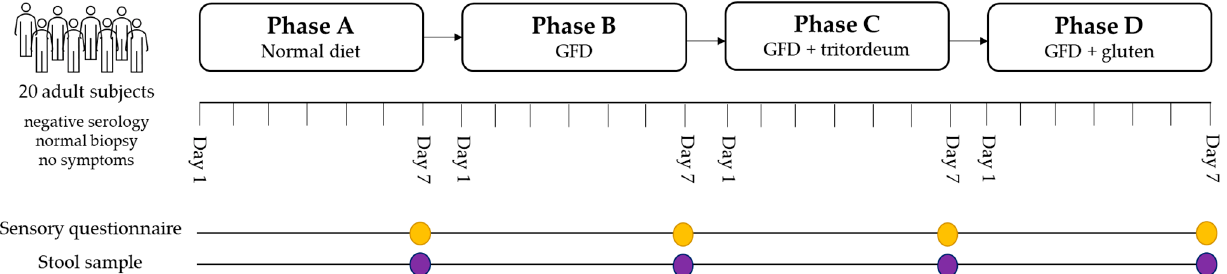
Figure 1. Study design. GFD: gluten-free diet.